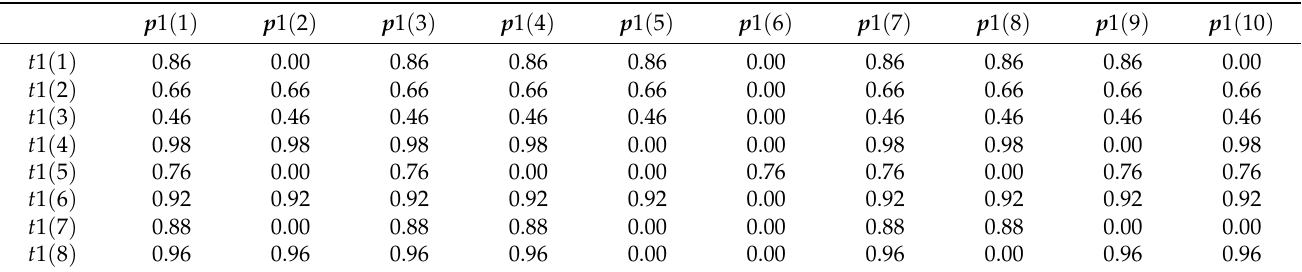
Table 2. Tourist-needs weighted matrix and the once-visited scenic spots functional attribute- weighted evaluation data.